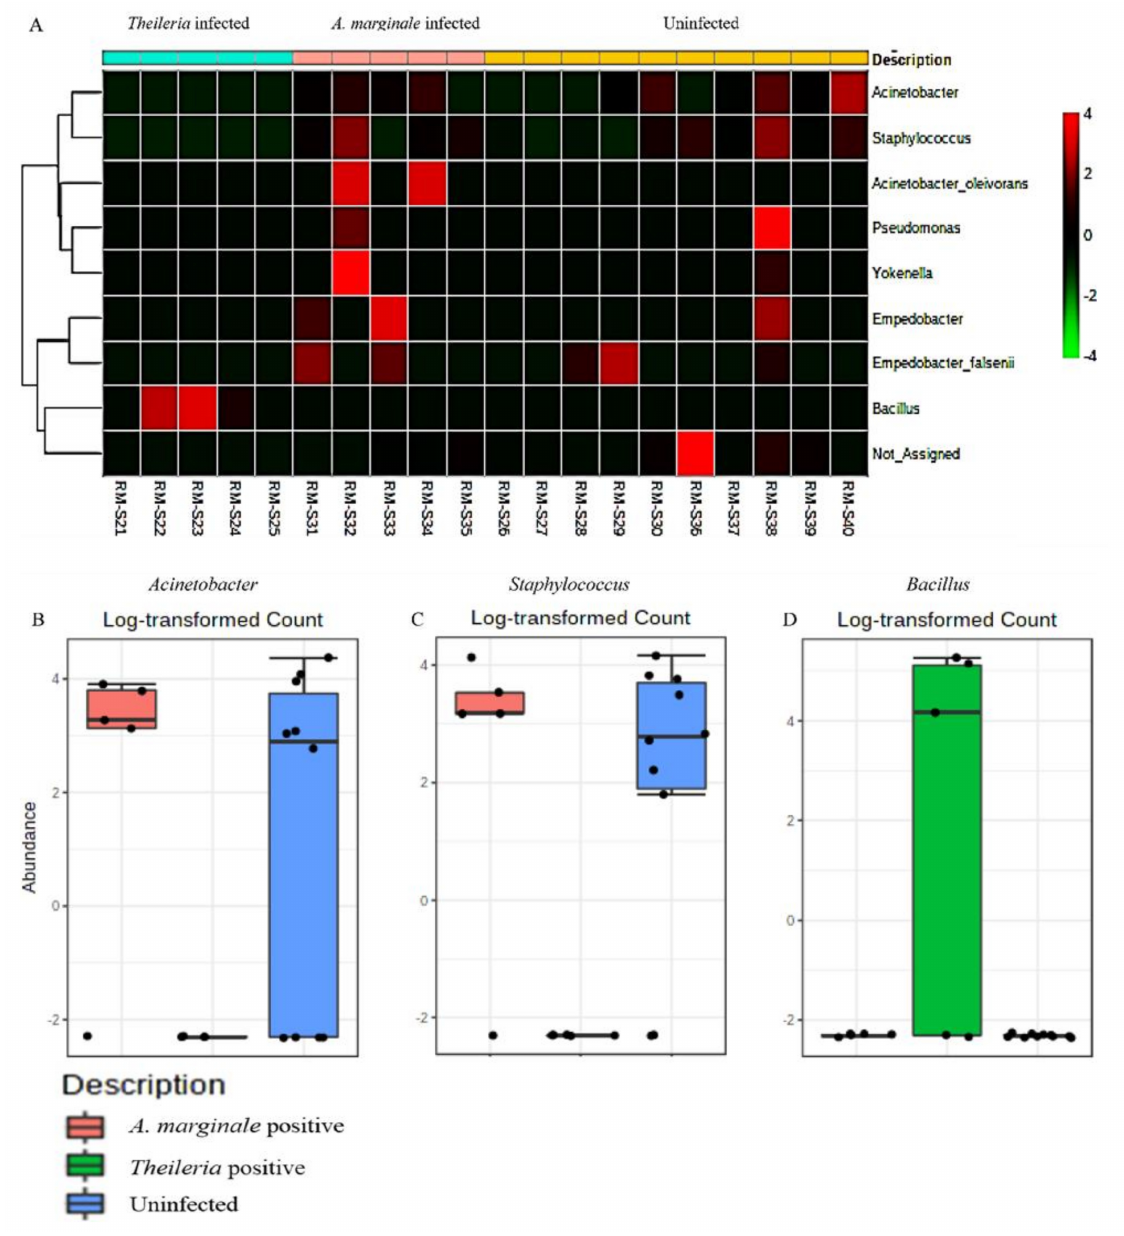
Figure 6. Heat map and classical univariate compositional analysis in R. microplus ticks. ( A ) Heat map correlation analysis between A. marginale positive, Theileria sp. positive and uninfected ticks. Log-transformed count of ( B ) Acinetobacter (FDR = 0.19277, df = 1, p -value = 0.007), ( C ) Staphylococcus (FDR = 0.19277, df = 1, p -value = 0.007), and ( D ) Bacillus (FDR = 0.0002, df = 1, p -value = 3.94e-223) in A. marginale positive, Theileria sp. positive and uninfected R. microplus